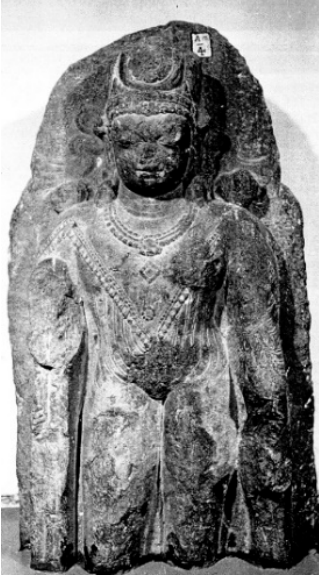
Figure 13. Buddha wearing a crown and jeweled cape with a crescent moon and sun symbols, eighth